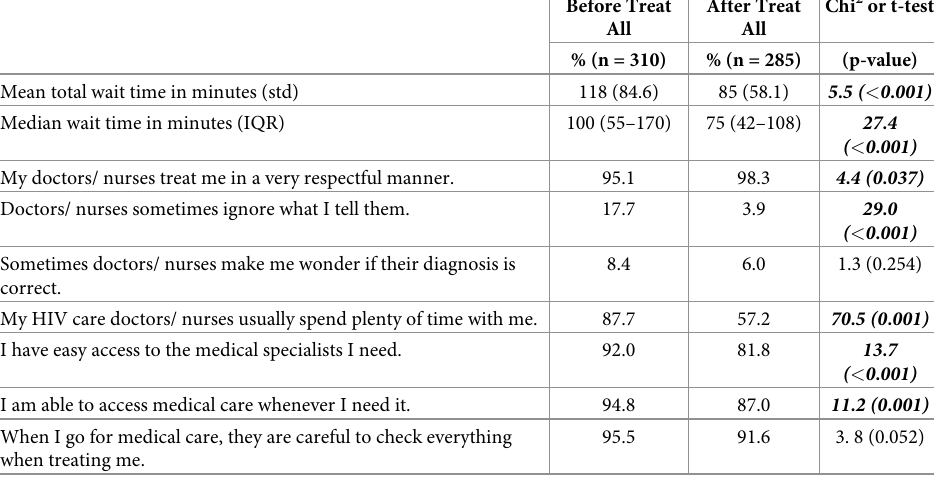
Table 5. Wait time and perception of service quality (proportion who agreed/strongly agreed with each statement).